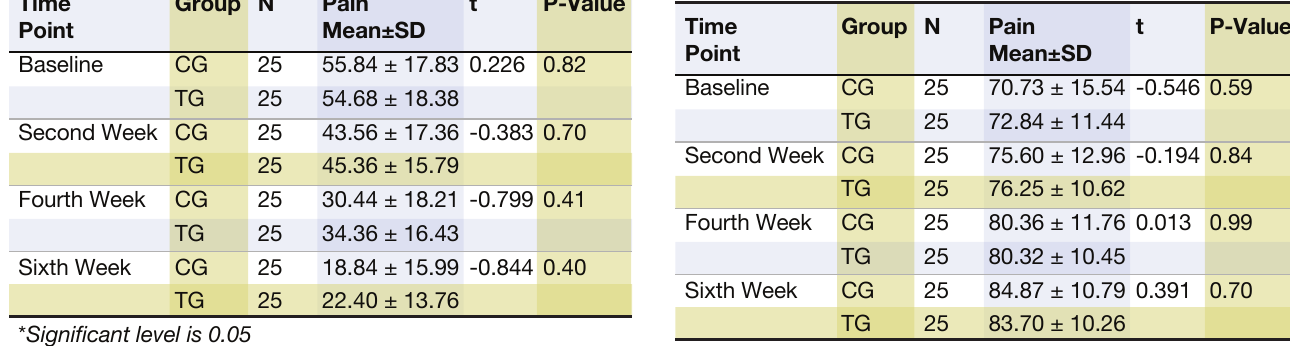
Table 11. Between Group Comparison of Participants’ Physical Function at Baseline, Second, Fourth and Sixth Week of Intervention